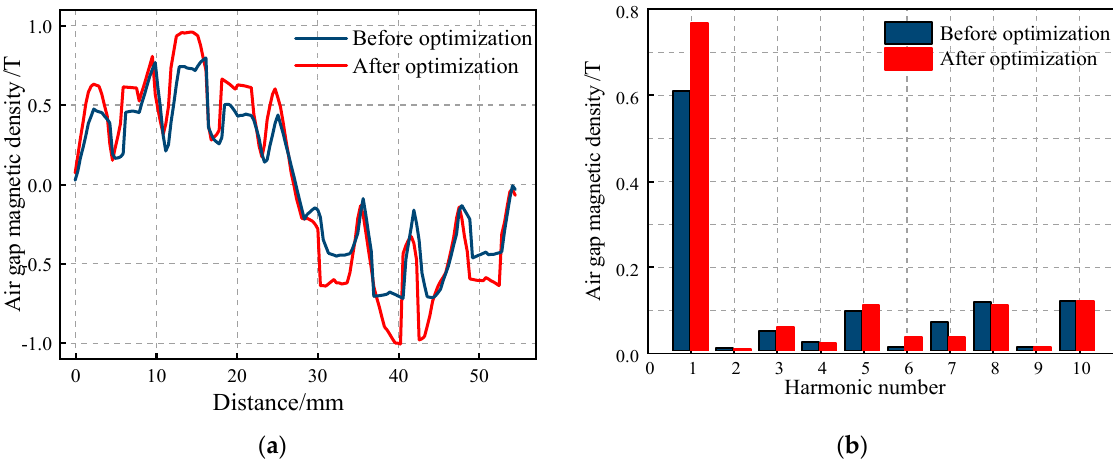
Figure 20. Comparison of the air gap magnetic flux density of the salient-pole rotor before and after optimization. ( a ) Comparison of the air gap magnetic flux density curves; ( b ) comparison of the air gap magnetic flux density harmonic distribution.